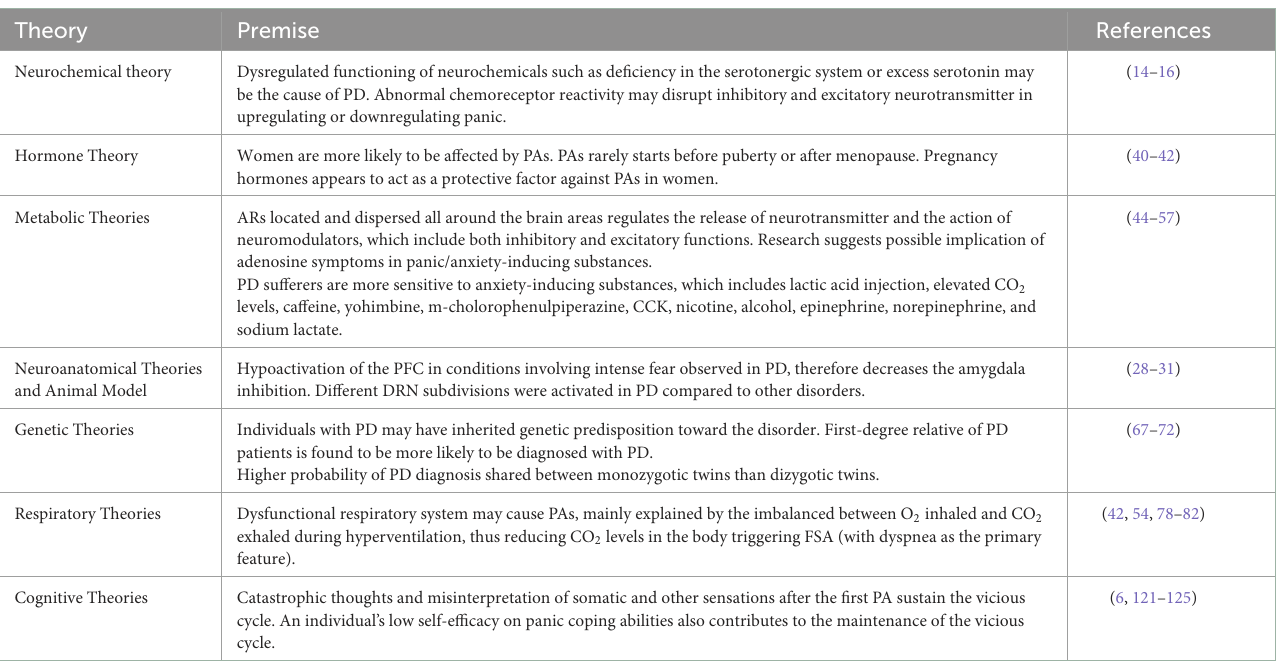
TABLE 1 The summary of theories explaining the etiology of